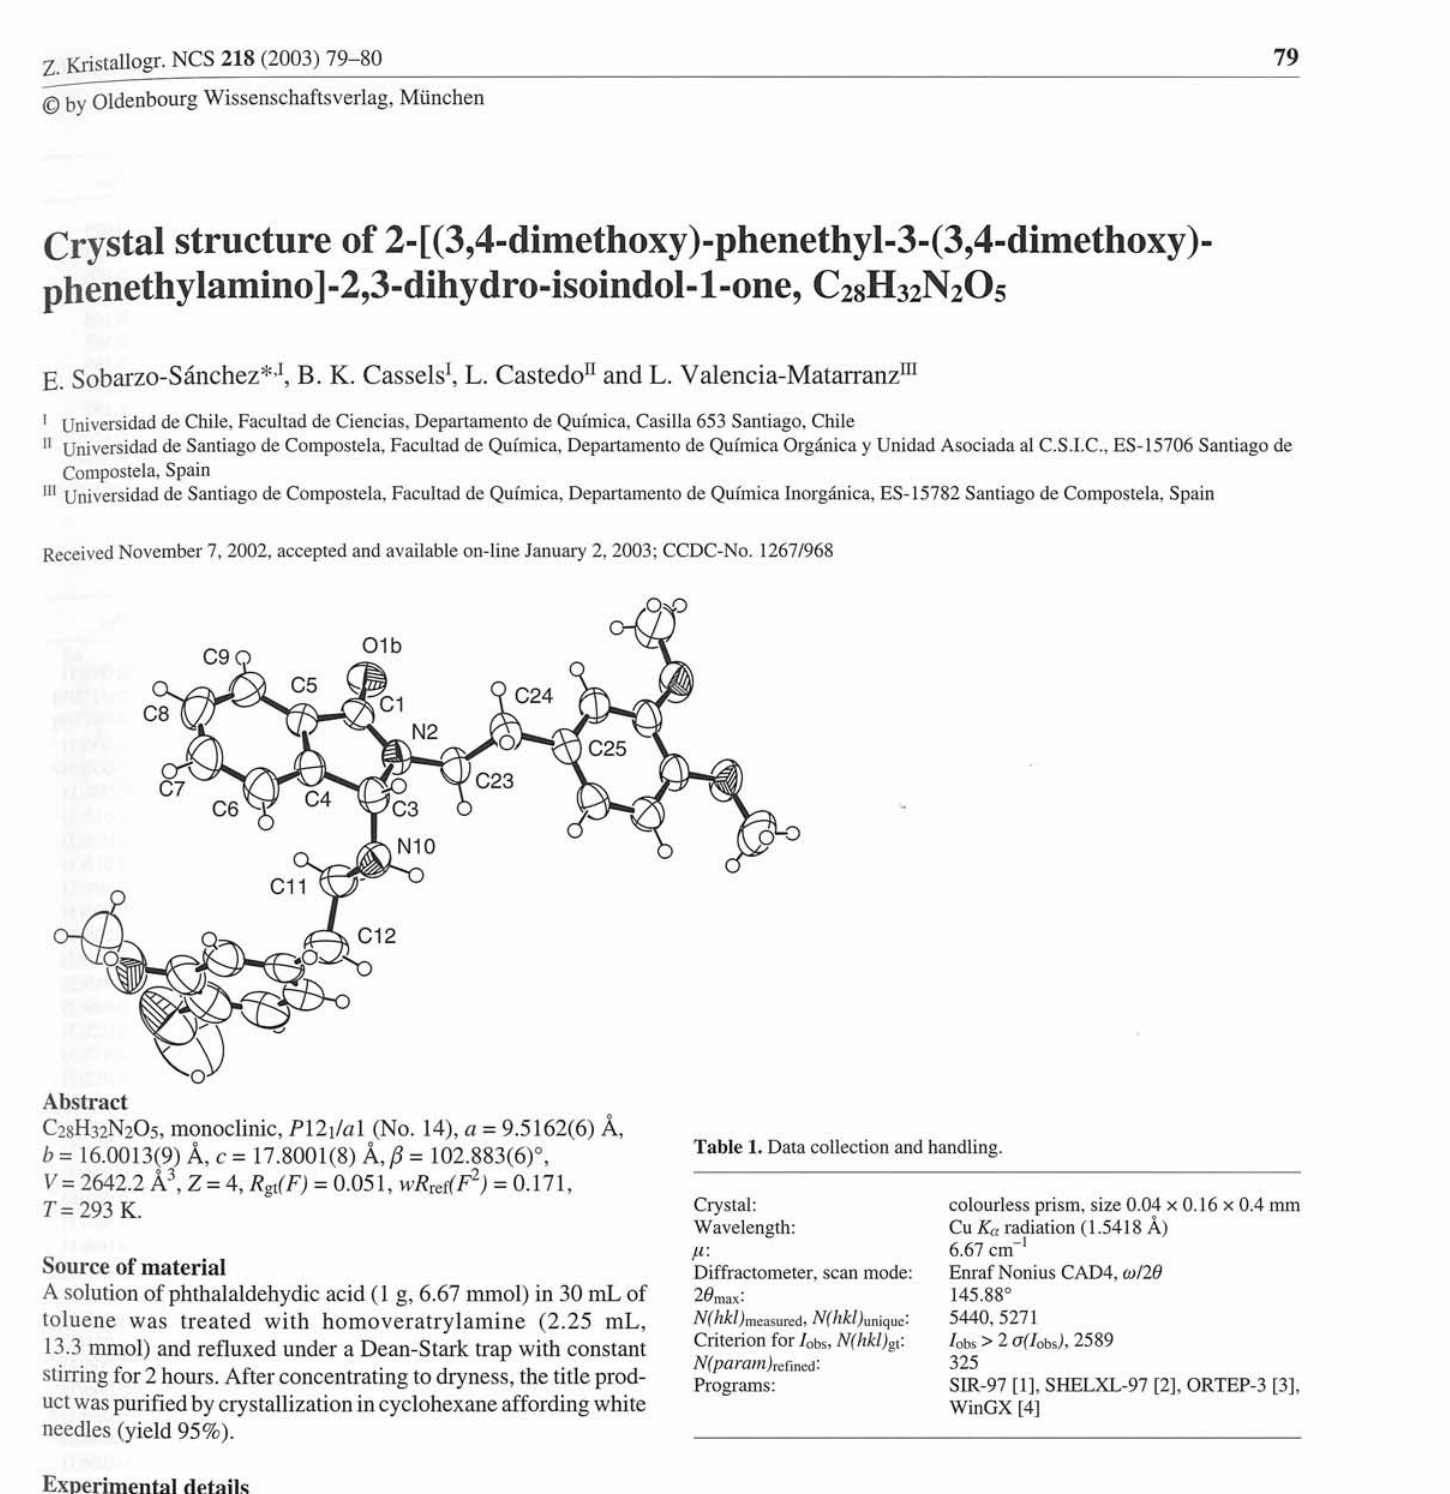
Table 1. Data collection and handling.